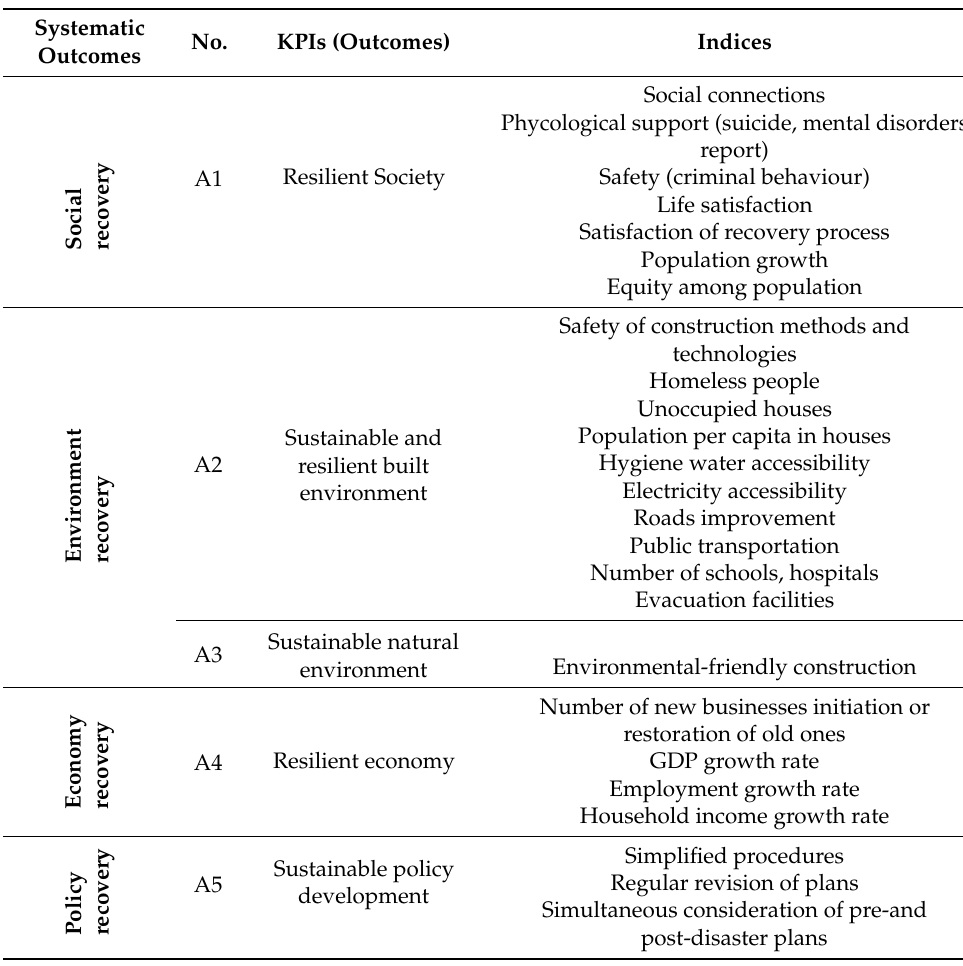
Table 3. Table of KPIs (outcomes).